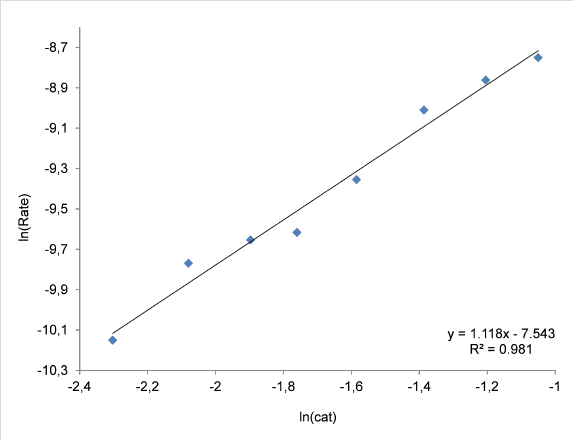
Figure 8: Double logarithmic plot to determine the order in Zn com- plex 2 . Conditions: 1,2-epoxyhexane (10 mmol) as substrate, 80 °C, 1 MPa of CO 2 , 2 h; [2] = 0.205–0.69 mol %. For the steady state domain using two different concentrations of bifunctional catalyst please refer to Supporting Information File 1, Figure